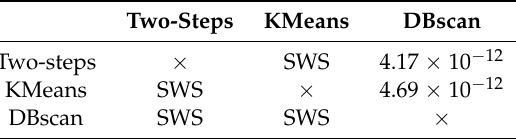
Table 13. p -values for instance c.5.